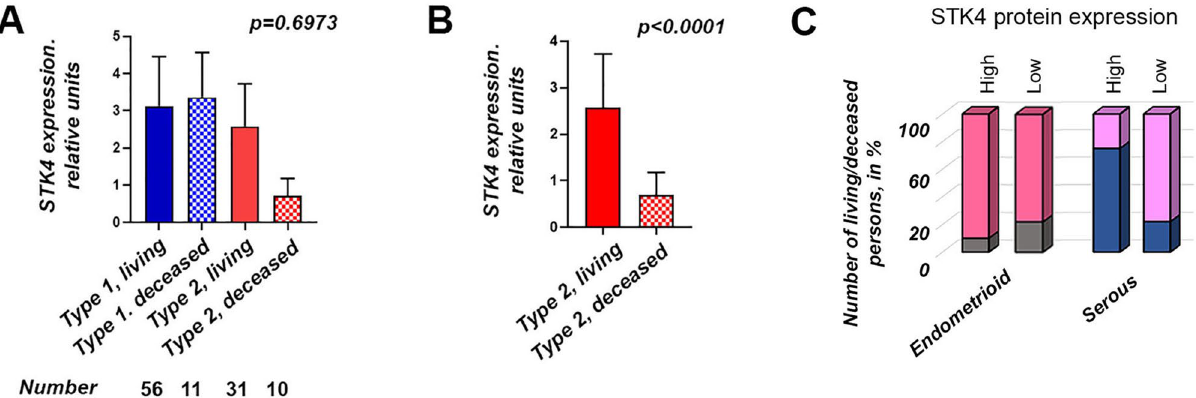
Figure 5. STK4 expression and 5-year survival of patients with EC. ( A ) STK4 protein expression shows a trend to decrease in Type 2 EC samples of deceased patients, i.e., in poorly differentiated cancers; bars in solid colors represent living individuals, bars with patterns—deceased patients; ( B ) as in ( A ), however, this phenomenon is better recognized in individuals with the Type 2 EC; ( C ) overall survival of patients with endometrioid (left two bars) and serous (right two bars) EC; high (above median) STK4 expression is associated with poor prognosis for patients with serous tumors (pink—% of living patients, blue—% of deceased patients). Endometrioid Serous